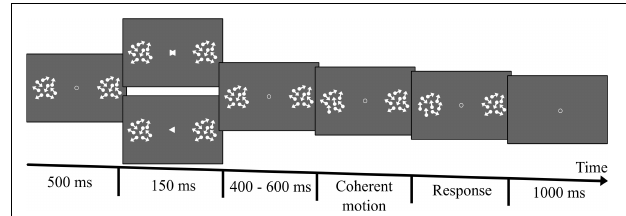
FIGURE 1 | Illustration of one trial of the main experiment. A trial began with the presentation of a fixation point at the center of the screen. Two Random Dots Displays (RDDs) were then displayed only if participants kept their eyes on the fixation for at least 200 ms. More specifically, the verification of fixation was performed for a maximum time period of 1 s. If during that time period, participants did not fixate for at least 200 ms, the trial was interrupted and a calibration was proposed. A cue was presented 500 ms after the presentation of the RDDs. In the attention trials the cue was an arrow pointing either to the left or the right RDD and indicating where a coherent motion (upward or downward) would appear (left or right). The cue was displayed on the screen for 150 ms and was 100% valid. Cue orientation was selected randomly and equiprobably. 400, 500, or 600 ms after the onset of the arrow (each delay was selected on a random basis and equally often), the dots of the RDD indicated by the cue started to move coherently either upward or downward. The number of dots moving coherently increased linearly for 3000 ms until reaching a proportion equal to three times the threshold obtained in the preliminary experiment. At the end of the 3000 ms the number of dots moving coherently stopped increasing and coherent motion was displayed for additional 200 ms. Then, the dots disappeared and participants were required to not blink/move their eyes for additional 1000 ms. Participants were instructed to continuously monitor the cued RDD without moving their eyes, and to report the direction of coherent motion (upward or downward) as soon as they perceived it, by pressing one of two designated keys (the upward and downward arrows of the keyboard) with their right-hand index finger. The neutral trials were exactly the same, except that the arrows were replaced by a neutral cue created by the superposition of the two arrows. Attention and neutral trials were randomized and were presented equally